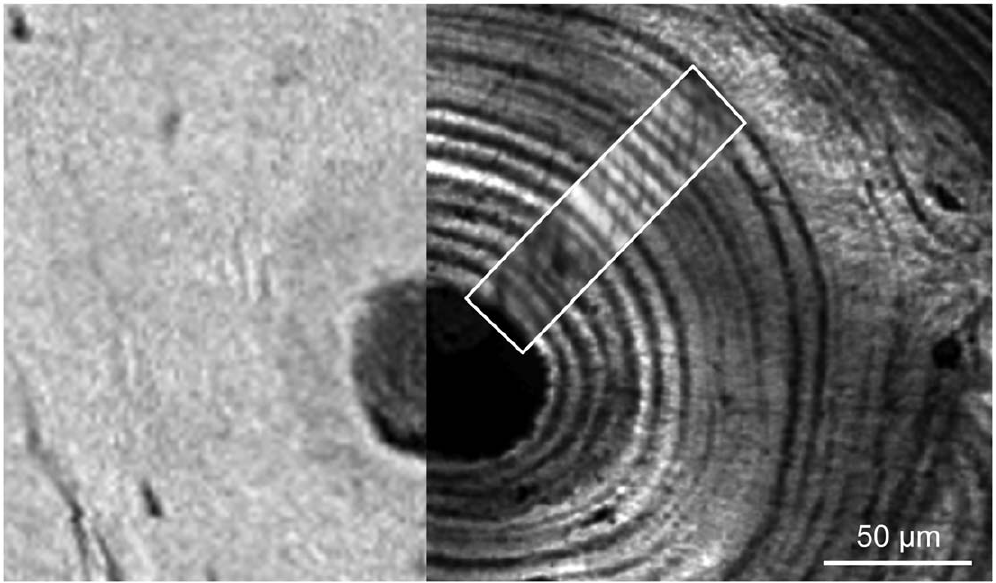
Figure 6. Site matched images on ost1 : DMB map (left), Z -map (right, background) and I SAXS map (right, foreground).